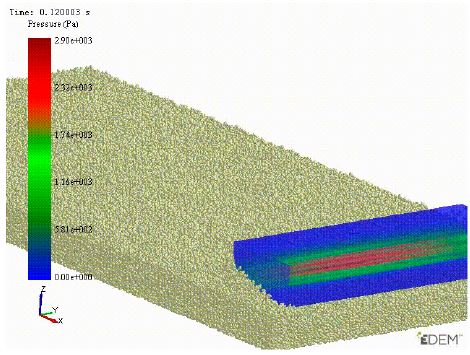
Figure 26. Force diagram when the skateboard is sliding.